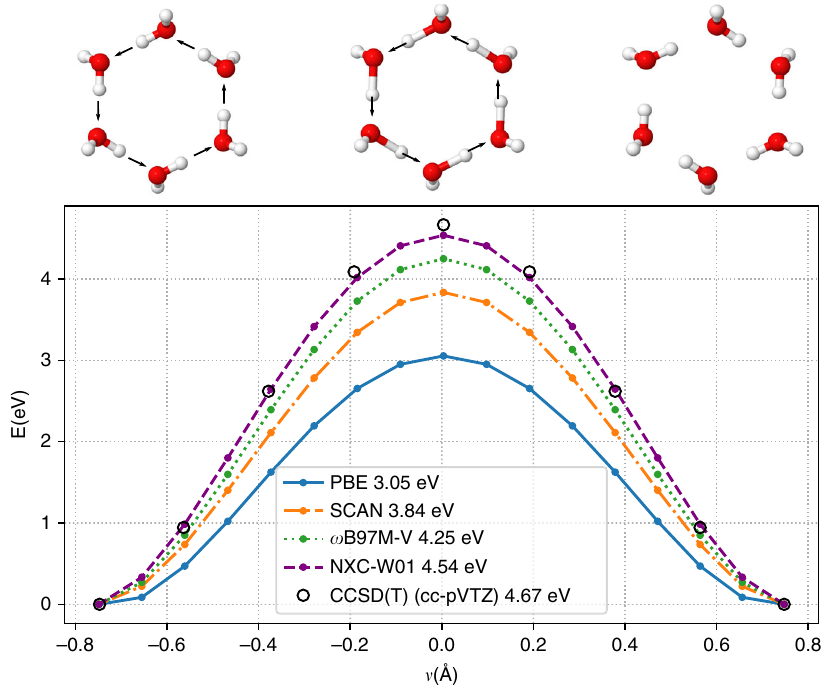
Fig. 6 Coordinated proton transfer in a water-hexamer ring. The reaction coordinate is de fi ned as ν ¼ d ð O (cid:2) H Þ (cid:2) d ð O 0 (cid:2) H Þ , where O ; O 0 are the two oxygen atoms involved in the H bond and H is the transferred proton. Energy values shown in inset correspond to barrier heights.